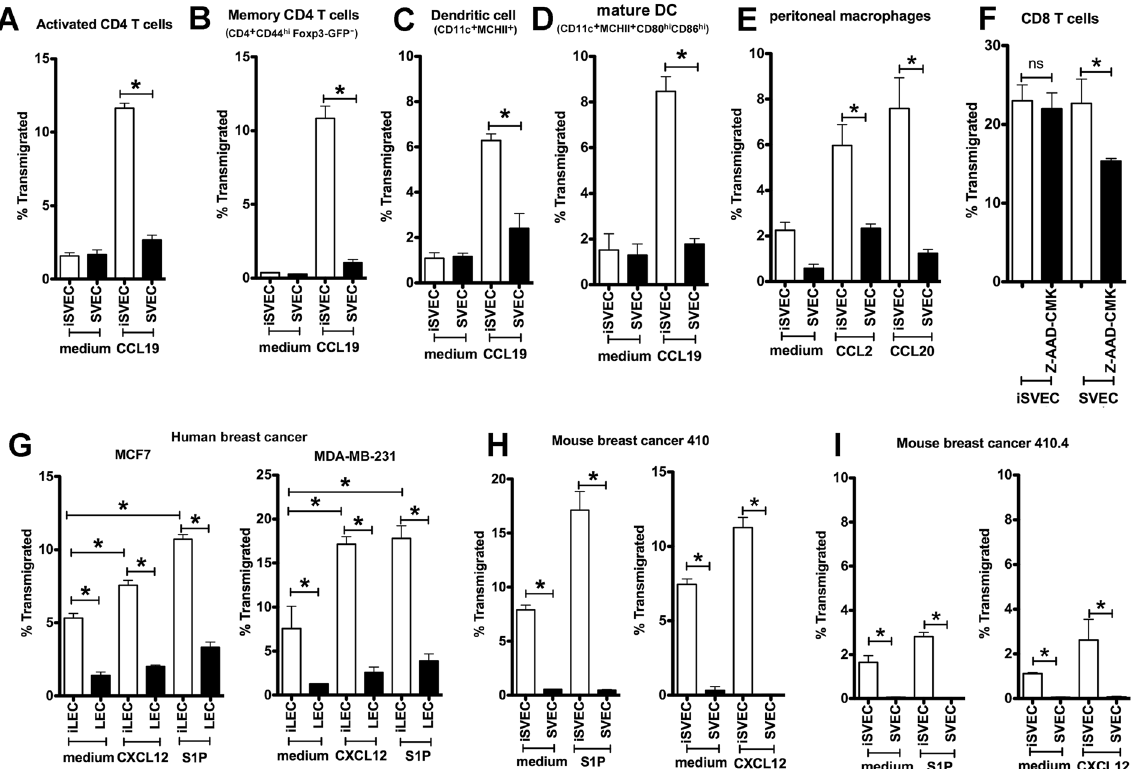
Figure 6. Diverse cell types migrate in a chemokine-driven vectorial fashion across LEC. ( A – D ) Activated CD4 T cells ( A ), memory CD4 T cells (CD4 + CD44 hi Foxp3-GFP − ) ( B ), DC (CD11c + MHCII + ) ( C ), and mature DC (CD11c + MHCII + CD86 hi CD80 hi ) ( D ) migration across iSVEC4-10 or SVEC4-10 toward CCL19. ( E ) Peritoneal macrophages migration toward CCL2 and CCL20 across iSVEC4-10 or SVEC4-10. ( F ) CD8 T cells migration across iSVEC4-10 or SVEC4-10 toward CCL19. ( G ) Human breast carcinoma lines MCF7 (left) and MDA-MB-231 (right), migration across hLEC and ihLEC toward S1P and CXCL12. ( H , I ) Mouse breast cancer cell lines 410 ( H ) and 410.4 ( I ) migration across SVEC4-10, iSVEC4-10, toward S1P or CXCL12. Representative of three independent experiments with triplicate wells in each assay * P <